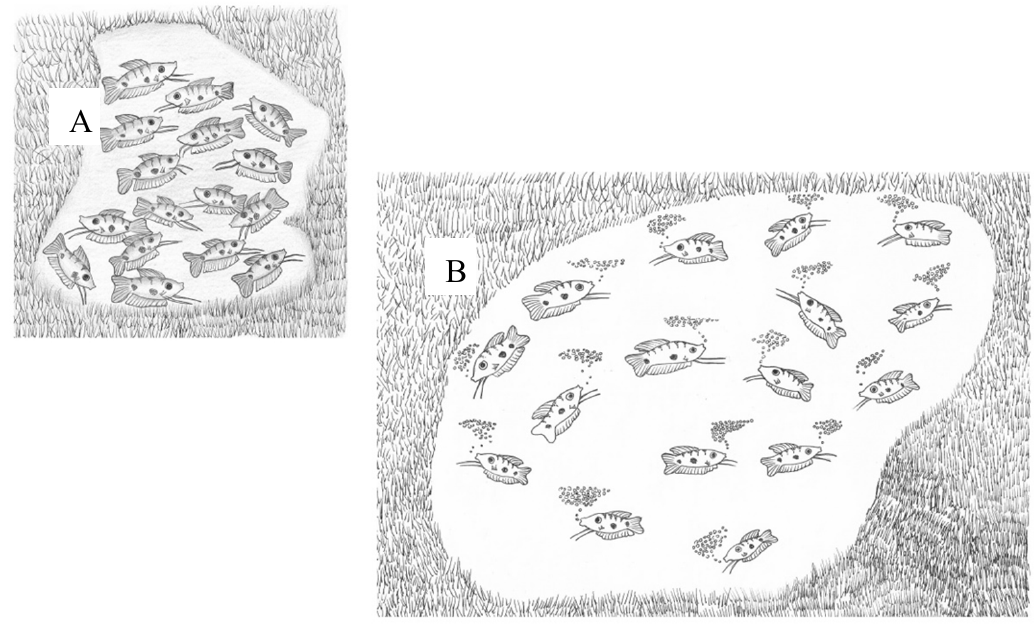
Figure 2. A scheme of two habitats, with high ( A ) and low ( B ) densities of males. At high density, the male does not build a nest. At low density, the male builds a nest and sexual behavior is initiated [10,13,14]. After courting and fertilization, the female swims under the bubble nest and spawns eggs into it. The male guards the nest with the eggs. If an egg falls out, the male returns it to the nest. The male also protects the young fish, immediately after hatching (Figure 3). Figure 3. Sexual behavior of male blue gourami during the reproductive cycle. (1) The male builds a nest. (2) and (3) The male courts the female under the nest. (4) Fertilization takes place and the fertilized eggs float up and stick to the bubble nest. (5) The male guards the eggs in the nest. (6) The male further protects the fry immediately after hatching while they swim in the nest area [10,13]. Ornamental fish populations in their native habitats, mainly in tropical areas, have declined due to overfishing for their sale on the tropical fish market. Fish of the subor- der Anabantoidei are important in the ornamental fish industry and have long been produced in aquaculture [10]. The introduction of T. trichopterus in Florida is considered to have failed, according to US Fish and Wildlife Service, June 2019 [11]. 2. Sequencing Analysis of the 12S rRNA and Cytochrome b Gene Variations in Blue Gourami Information on the molecular variation of species belonging to the Anabantoidei in the order Perciformes (perch-like-fishes) is very limited [2,15,16]. Polymorphisms in several enzymes can be utilized as a genetic marker for these Anabantoidei species be- longing to the Perciformes [5,17]. Thus, two Anabantoidei species— Trichogaster trichopterus and Trichogaster leerii— are similar in morphology and in their geographical distribution. Colisa lalia does not